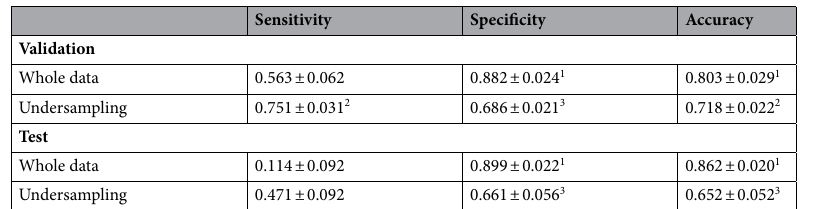
Table 5. Cross table of PCR results and predictions. Cross tables on PCR-results and RNN-predictions are made on the RNN-predictions on 200-epochs. Set numbers on RNN-prediction of the test data (C, D) were shown on each learned group on which prediction algorithm was created by learning. Data from prediction on group 1 is shown on C and D, average and standard deviations on prediction from 5 groups are listed in Table 6.